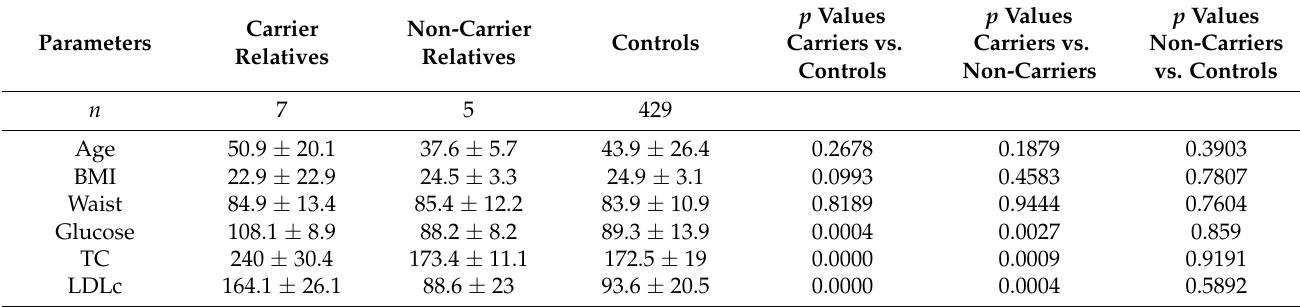
Table 1. Comparison between carriers, non-carrier relatives and controls.